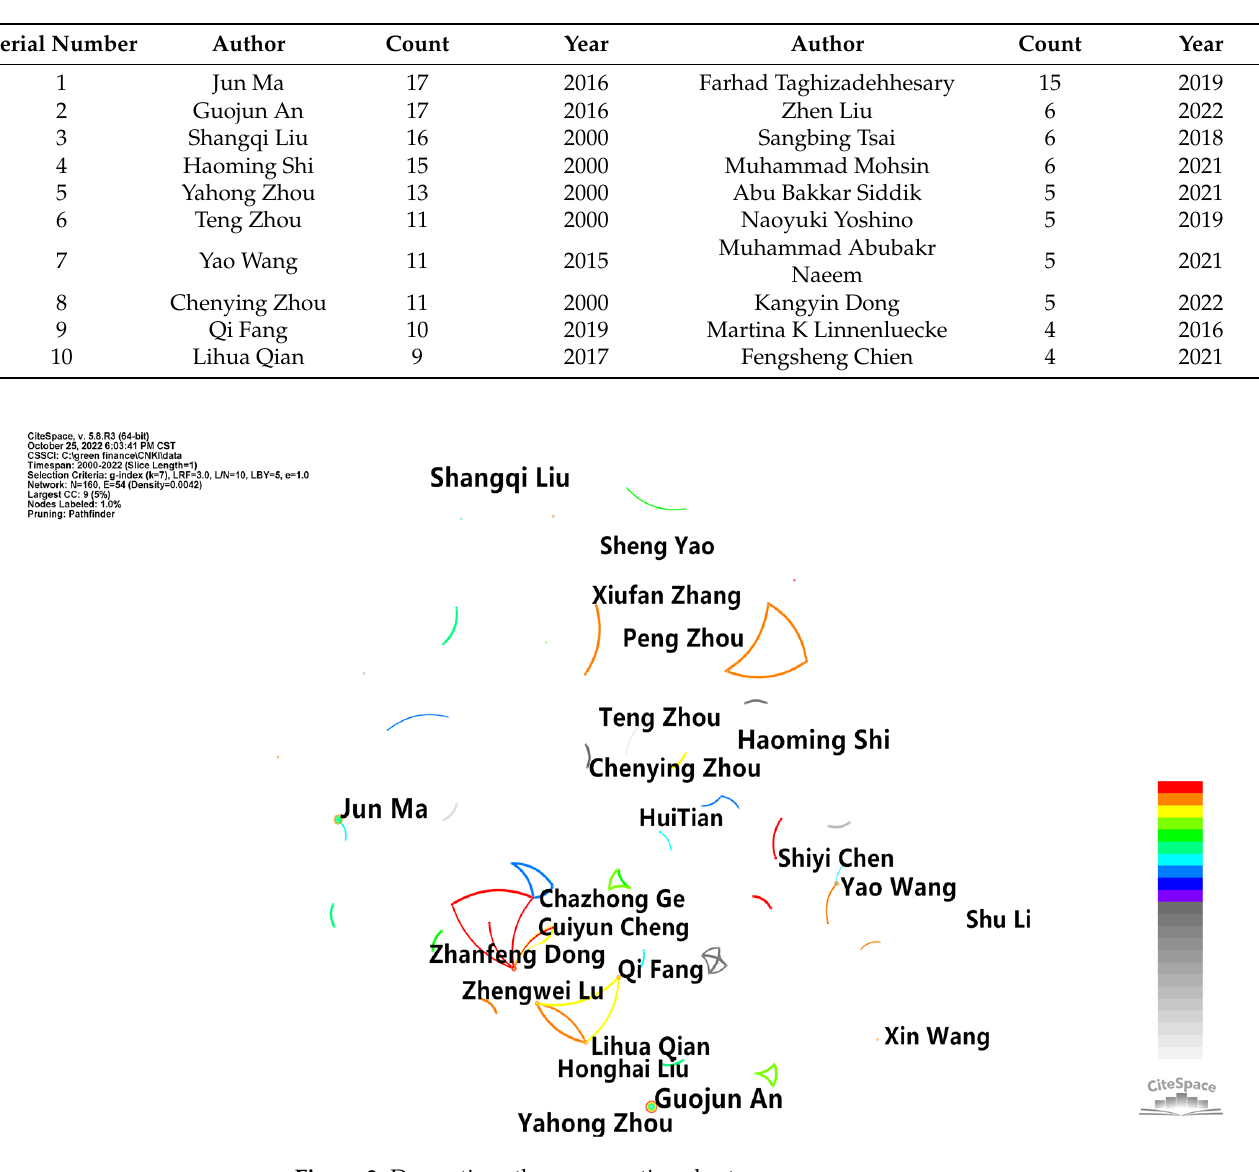
Figure 4. International author collaboration chart. In order to explore the cooperation of research institutions in the field of green fi- nance, a co-occurrence analysis was conducted on the signed institutions of the sample literature, and an institutional cooperation network map was obtained (Figures 5 and 6). The size of the tree rings was proportional to the number of publications, and the lines between the nodes and their thickness represent the cooperation relationship and cooper- ation frequency between institutions. As shown in Figure 5, the number of nodes in the cooperative network of the domestic research institutions was N = 122; the number of connections was E = 31; and the network density was D = 0.0042. In other words, 122 in- stitutions and 31 links between the institutions were selected in the knowledge map of